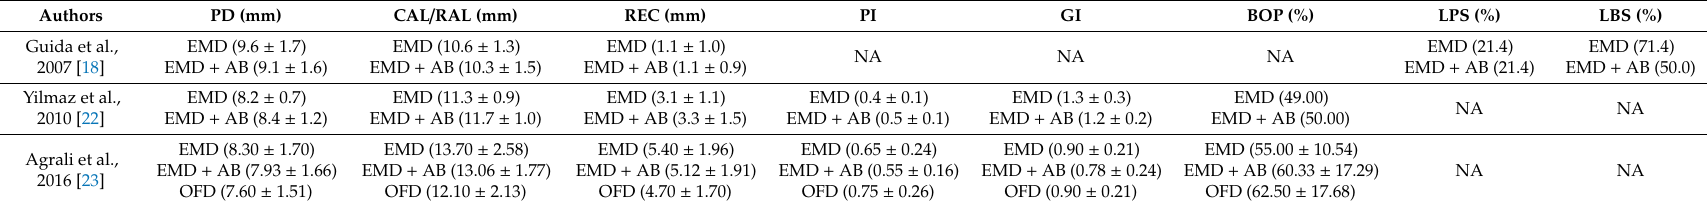
Table 5. Clinical characteristics of intrabony defects at baseline.